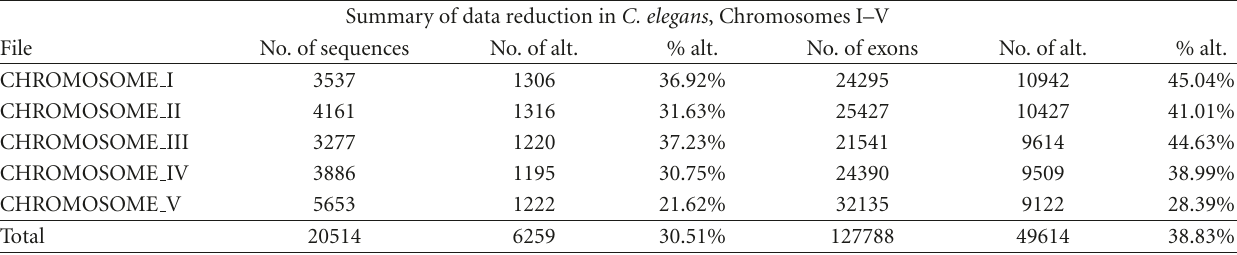
Table 1: Summary of data reduction in C. elegans , Chromosomes I–V.